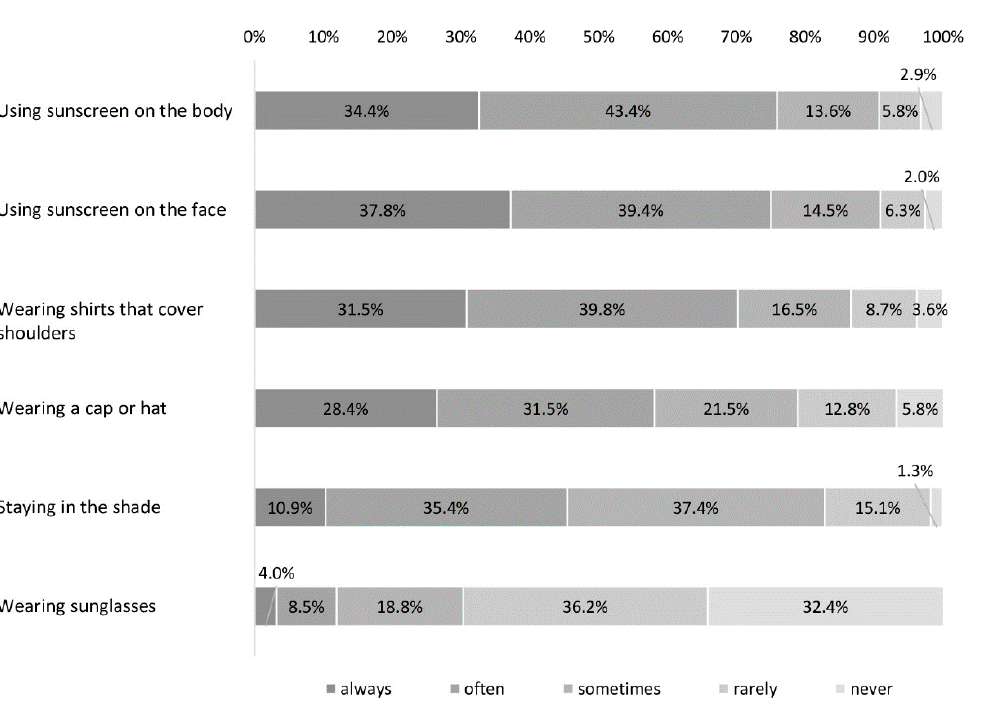
Table 2. Determinants related to the use of sun protection measures based on answers of 554 participants in wave 2020 of the National Cancer Aid Monitoring (NCAM). Sunscreen on the Body